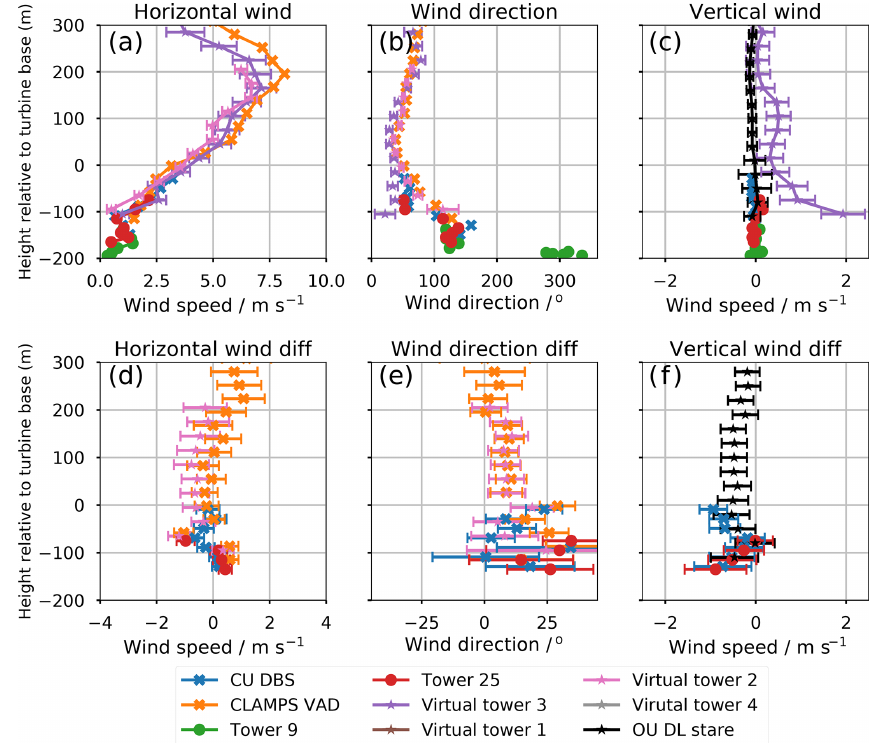
Figure 6. Profiles of horizontal wind speed (a) , wind direction (b) , and vertical velocity (c) of the CU DBS (blue), CLAMPS VAD (orange), VT2 (pink, 2D), VT3 (purple, 3D), Tower 25 (red), and Tower 9 (green) from 12 June 2017 at 02:55UTC (discussed in Sect. 4.1.1). Additionally, profiles of the difference relative to VT3 are shown (d–f) . VT4 and VT1 are not available for this time period due to DL malfunction and not meeting retrieval criteria, respectively. Note the height axis is relative to the base of the wind turbine, which is a proxy for the height of the ridge. Additionally, the error bars on the CLAMPS DL stare profile (f) are the standard deviation of the vertical velocities observed between 1min before and 1min after the virtual-tower time. Uncertainty is propagated through the difference, hence the appearance of error bars on Tower 9, Tower 25, and the CLAMPS VAD in (d–f)